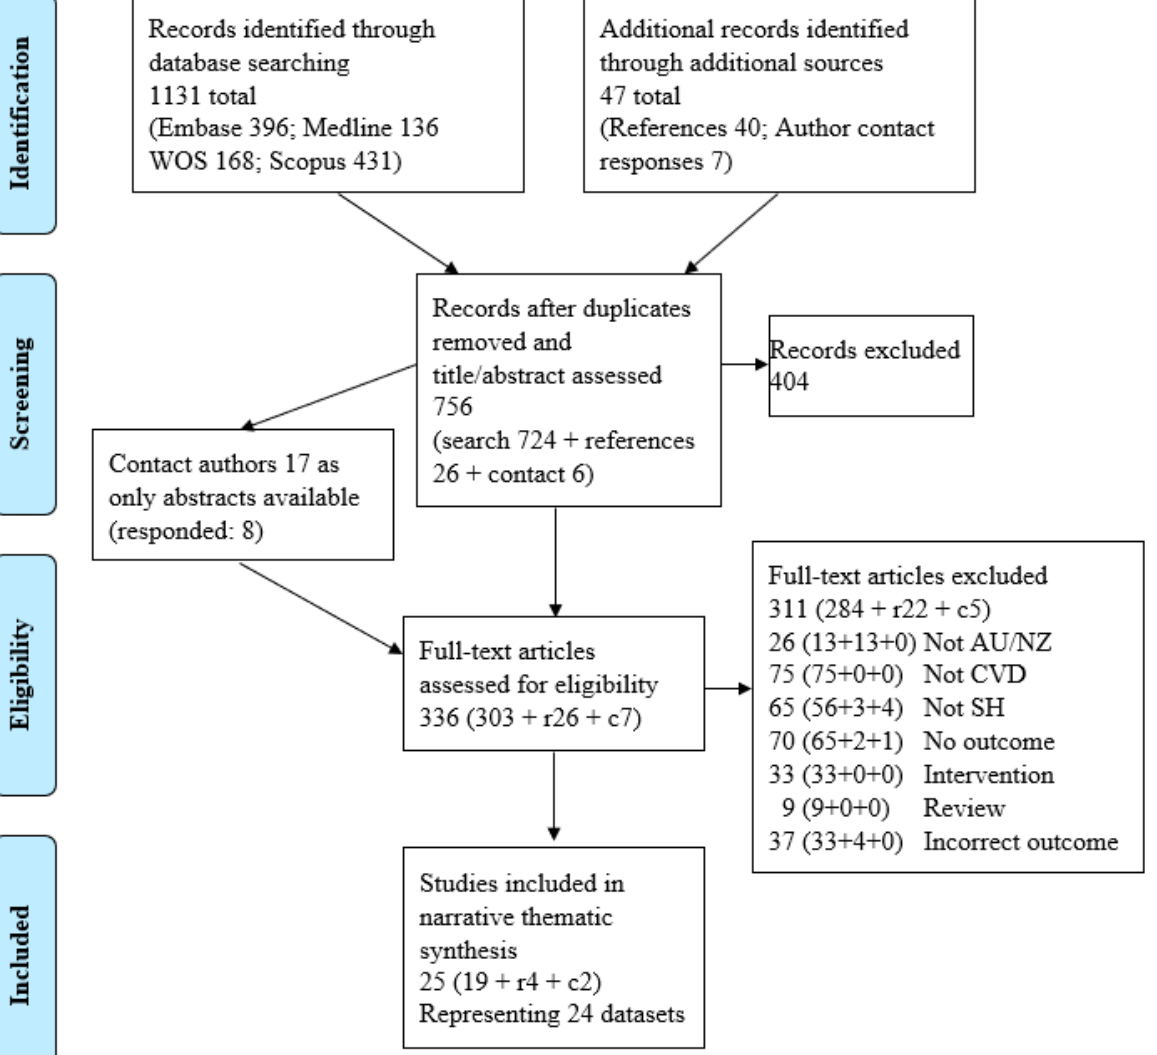
Figure 1. Flow Diagram of Review Process. Acronyms: AU—Australia; c—contact (number of papers from contact with authors of included papers); CVD—Cardiovascular Disease; Datasets—number